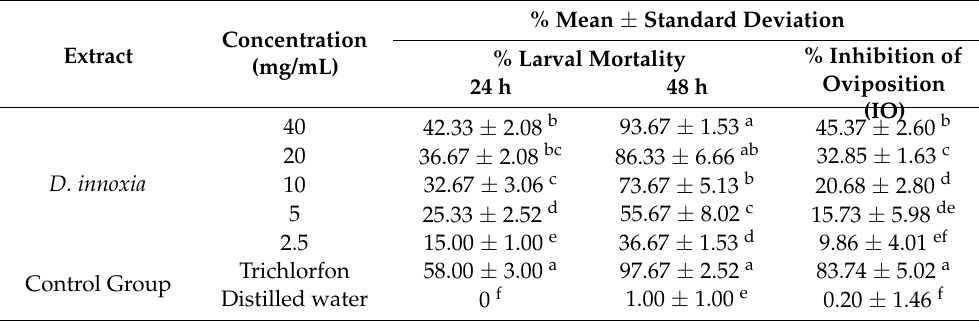
Table 1. Mean % larval mortality and inhibition of oviposition at different concentrations of D. innoxia plant extract against R. microplus in vitro in LPT and AIT, respectively.